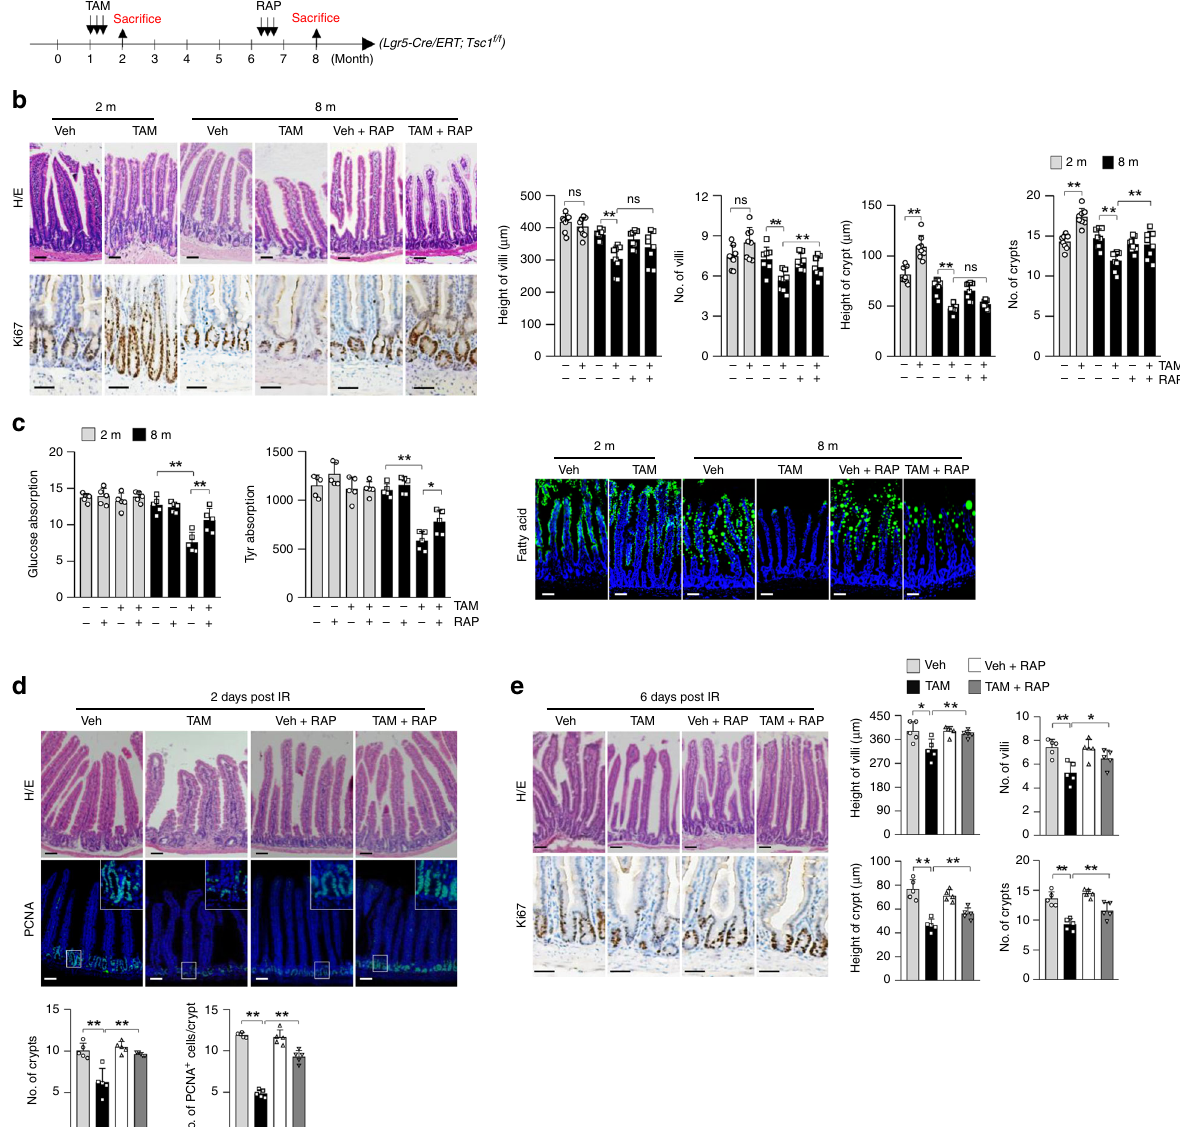
Fig. 2 Deletion of Tsc1 in Lgr5 + ISCs leads to villus premature aging. a A schematic for conditional ablation of Tsc1 and RAP treatment in Lgr5-CreERT; Tsc1 f/f mice ( b – e ). b H/E and Ki67 staining showed that ablation of Tsc1 in Lgr5 + ISCs led to crypt overgrowth at 2 months of age and deterioration of villus structure (the midline section of the proximal jejunum) at 8 months of age, which were partially rescued by RAP. Right panels: quanti fi cation data (mean ± SEM). N = 8 mice per group. ** P < 0.01 (determined using Student ’ s t test). c Eight-month-old Lgr5-CreERT;Tsc1 f/f mice showed decreased nutrient absorption activities for L-glucose (mmol/l), amino acids (ng/ml), and fatty acids, which were partially rescued by RAP treatment. Data are expressed as mean ± SEM. N = 5 mice per group. * P < 0.05, ** P < 0.01 (determined using Student ’ s t test). d , e Eight-month-old Lgr5-CreERT;Tsc1 f/f mice showed increased sensitivity to IR-induced decreases in the numbers of crypts and proliferating cells at day 2 post IR ( d ), and compromised regeneration (decreases in the height and number of villi and crypts) at day 6 post IR ( e ), which were partially rescued by RAP treatment. Data are expressed as mean ± SEM. N = 5 mice per group. * P < 0.05, ** P < 0.01 (determined using Student ’ s t Tsc1 -de fi cient crypts showed increased growth in organoid cultures; however, they lost the ability to propagate at passage 3 (Fig. 3d), con fi rming the biphasic roles of mTORC1 signaling in crypt growth and aging. Tsc1 ablation-induced premature villus aging was also associated with defects in ISCs. At 8 months of age, the number of crypts containing Lgr5-expressing ISCs and the number of Lgr5 + ISCs per crypt were decreased, whereas the opposite results were observed at 2-month-old Lgr5-CreERT;Tsc1 f/f mice (Fig. 3e).